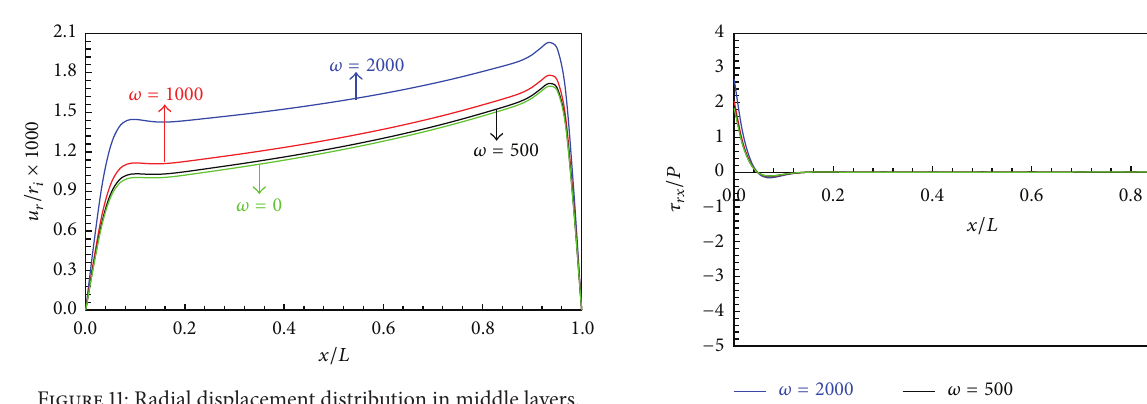
Figure 11: Radial displacement distribution in middle layers.